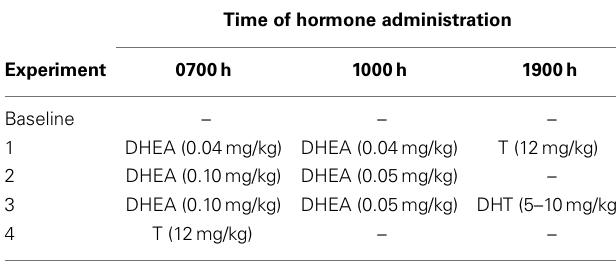
Table 1 | Steroid supplementation paradigms